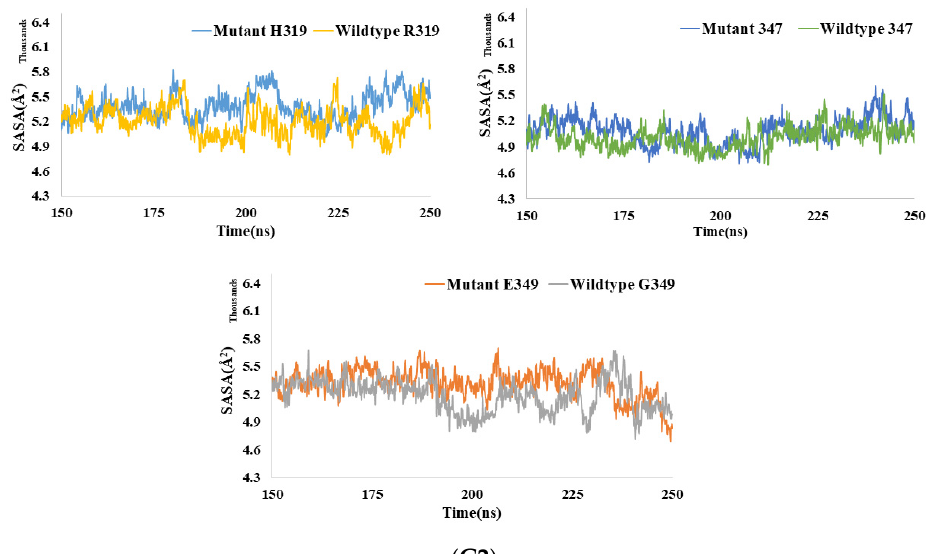
Figure 8. Analysis of RMSD, Rg, and SASA of wild-type and mutant TP63–DNA complexes at 250 ns. ( A1 ) RMSD values of the backbone of DNA-native and mutant structures. ( A2 ) RMSD values of respective wild-type–mutant pairs for 150–250ns simulations. ( B1 ) Rg values of the protein–DNA backbone over the entire simulation, ( B2 ) The simulations from150–250ns for respective mutant and native structures with DNA separately. ( C1 ) SASA values for native and mutant TP63 with DNA, and ( C2 ) the values of SASA for 150–250ns simulations for the individual pair. The symbol coding scheme is as follows: wild-type R319 (yellow color), mutant H319 (light blue color), E349 (red color), wild-type G349 (gray color), wild-type 347 (green color), and mutant 347 (blue color).